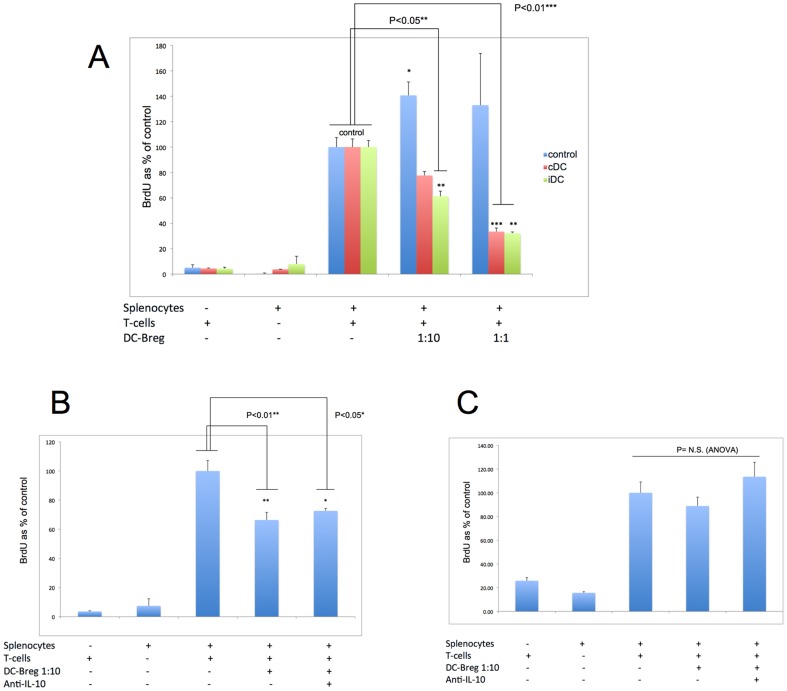
CD19+ B220+ CD11c− IL-10+ B-cells (DC-Bregs) are functionally-suppressive in allogeneic MLR in vitro and do not require IL-10 to mediate suppression.a. Quintuplicate wells of splenic T-cells, irradiated splenocytes (alone, together, or in the presence of CD19+ B220+ CD11c− IL-10+ B-cells) were incubated for 5 days. On the last day, BrdU was added. The number of BrdU+ cells was measured by flow cytometry on day 6. Cultures consisted of 1×105 T-cells from the spleen of NOD female mice (8 weeks), irradiated allogeneic splenocytes (C57BL/6 males, 8 weeks) and purified CD19+ B220+ CD11c− IL-10+ B-cells (combination of column enrichment and flow sorting as described in the Methods). Proliferation of only T-cells or splenocytes was taken to represent 100% proliferation in these analyses. The bars represent the mean of n = 5 wells and the error bars represent the SEM. The differences in proliferation in co-cultures of CD19+ B220+ CD11c− IL-10+ B-cells in the absence of cDC or iDC compared to those in the presence of the DC are statistically-significant (p values shown in graph on top of bars as single, double (p<0.05, ANOVA) or triple asterisks (p<0.01, ANOVA). The last two sets of bars compare the proliferation fo the T-cells at a 1∶10 and a 1∶1 ratio of DC-Breg: T-cell numbers. b. CD19+ B220+ CD11c− IL-10+ B-cells (DC-Bregs) are suppressive in allogeneic MLR even in the presence of a neutralising IL-10 antibody but not when physically separated from the T-cells/antigen-presenting cells. Quintuplicate wells of splenic T-cells, irradiated splenocytes (alone, together, or in the presence of DC-Bregs) were incubated for 5 days. The ratio of DC-Breg∶T-cell numbers was 1∶10 in all co-cultures. On the last day, BrdU was added. Anti-IL-10 antibody was added at 1 microgram/mL where shown. Proliferation of T-cells in the presence of irradiated splenocytes was taken to represent 100% proliferation. The bars represent the means of BrdU+ cells as a % of BrdU+ in the control T-cells∶splenocyte co-cultures (n = 5 wells) and the error bars represent the SEM. The differences in T-cell proliferation in co-cultures in the absence of DC-Bregs and those in the presence of DC are statistically-significant (p values shown in graph, ANOVA). c. DC-Bregs cannot suppress the proliferation of Transwell barrier-sequestered T-cells in allogeneic MLR in vitro. MLR was conducted with DC-Bregs added on top of a Transwell insert separating co-cultures of T-cells and allogeneic irradiated splenocytes. The ratio of DC-Breg∶T-cell numbers was 1∶10 in all co-cultures Anti-IL-10 antibody was added at 1 microgram/mL where shown on top of the Transwell insert (with the DC-Bregs). Proliferation of cells in the bottom of the dish (T-cells∶splenocyte co-cultures) in the absence of DC-Bregs was taken to represent 100% proliferation in these analyses. N = 5 wells for each co-culture shown. N.S. = differences among means were not significant (p>0.05).